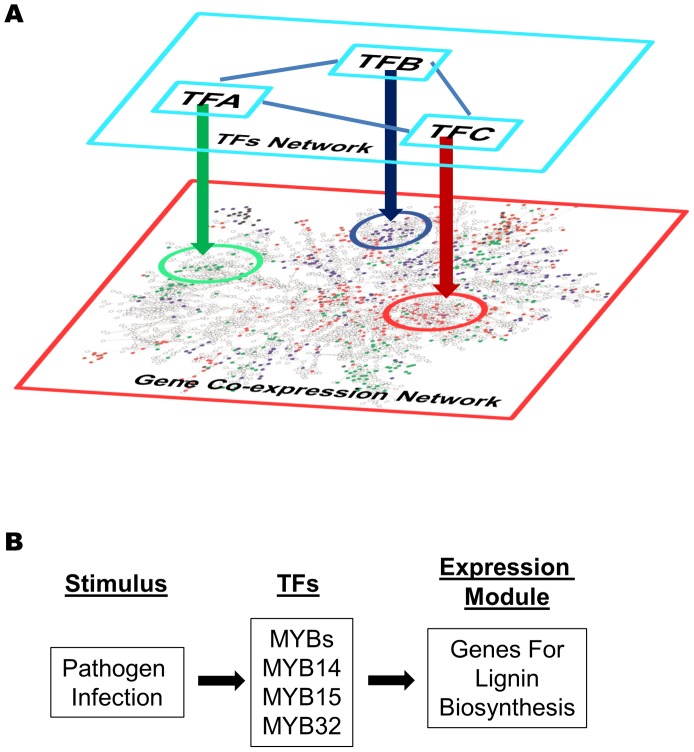
Gene expression modules regulated by transcription factors in a gene co-expression network.(A) Different modules in a gene co-expression network are regulated by different transcription factors (TF-A, TF-B, TF-C etc). These transcription factors are not necessary part of the co-expression network, and they might interact with each other and form a regulatory network of themselves. (B) A gene expression model derived from the network analysis. The MYB transcription factors (MYB14, 15, and/or 32) are activated upon pathogens infection and turn on the expression of down-stream lignin biosynthesis genes (described in Figure 4 Module V).